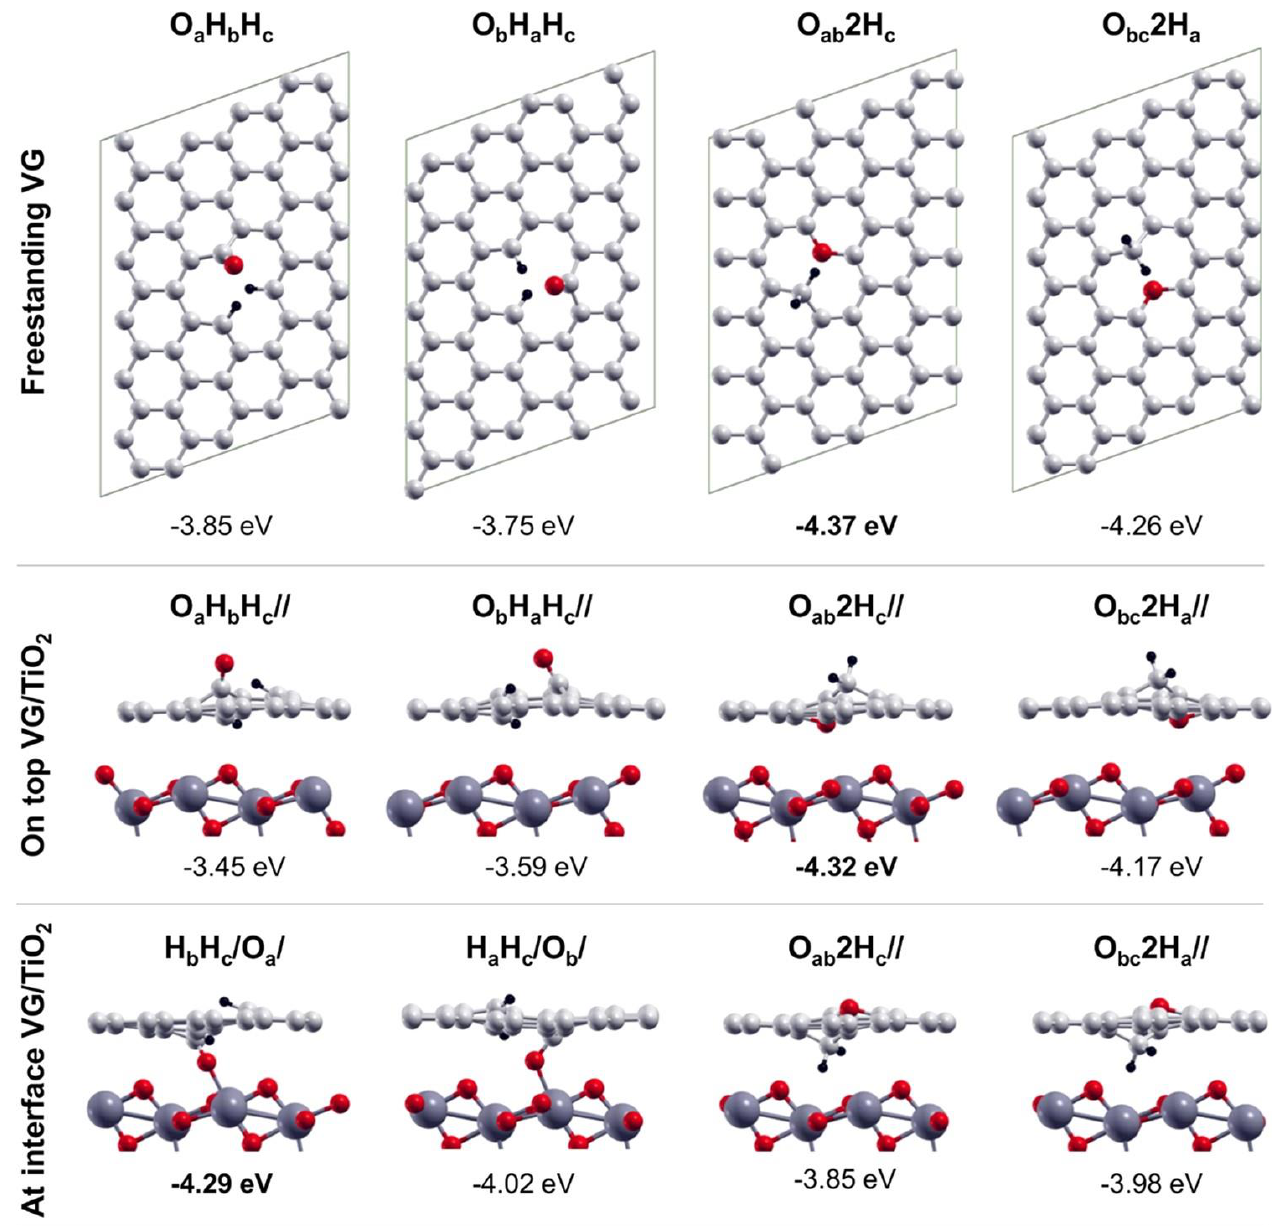
Figure 4. Top views of the fully dissociated products of water on freestanding VG (top line); side views of the fully dissociated products of water (O + H + H) on top of VG/TiO2 (middle line), and at the interfaces of VG/TiO 2 (bottom line). Small red, light grey, and black balls represent O, C, and H atoms, respectively. Big dark grey balls represent Ti atoms. Taken with permission from Ref. [14]. Copyright by ACS.